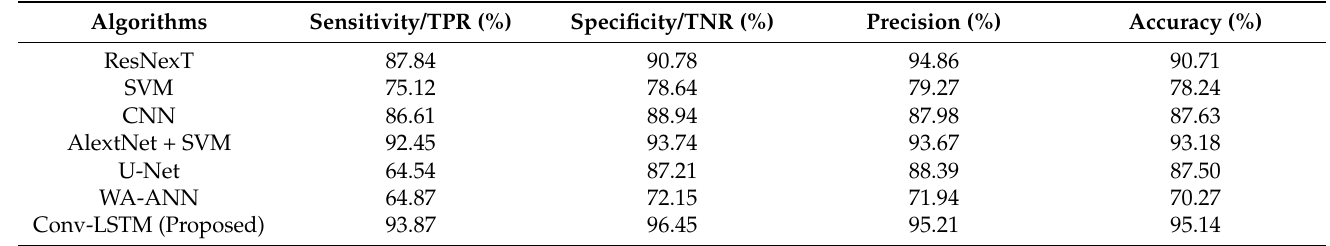
Table 7. Comparative result analysis of proposed model with other state-of-art